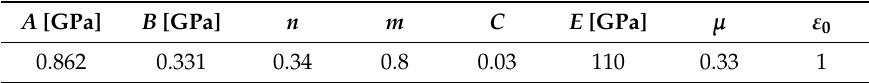
Table 1. Titanium alloy Johnson–Cook material model